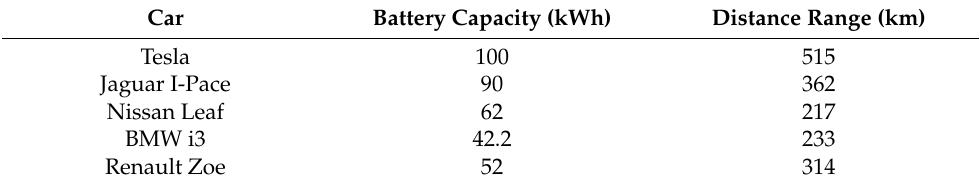
Table 1. Car data 1 .